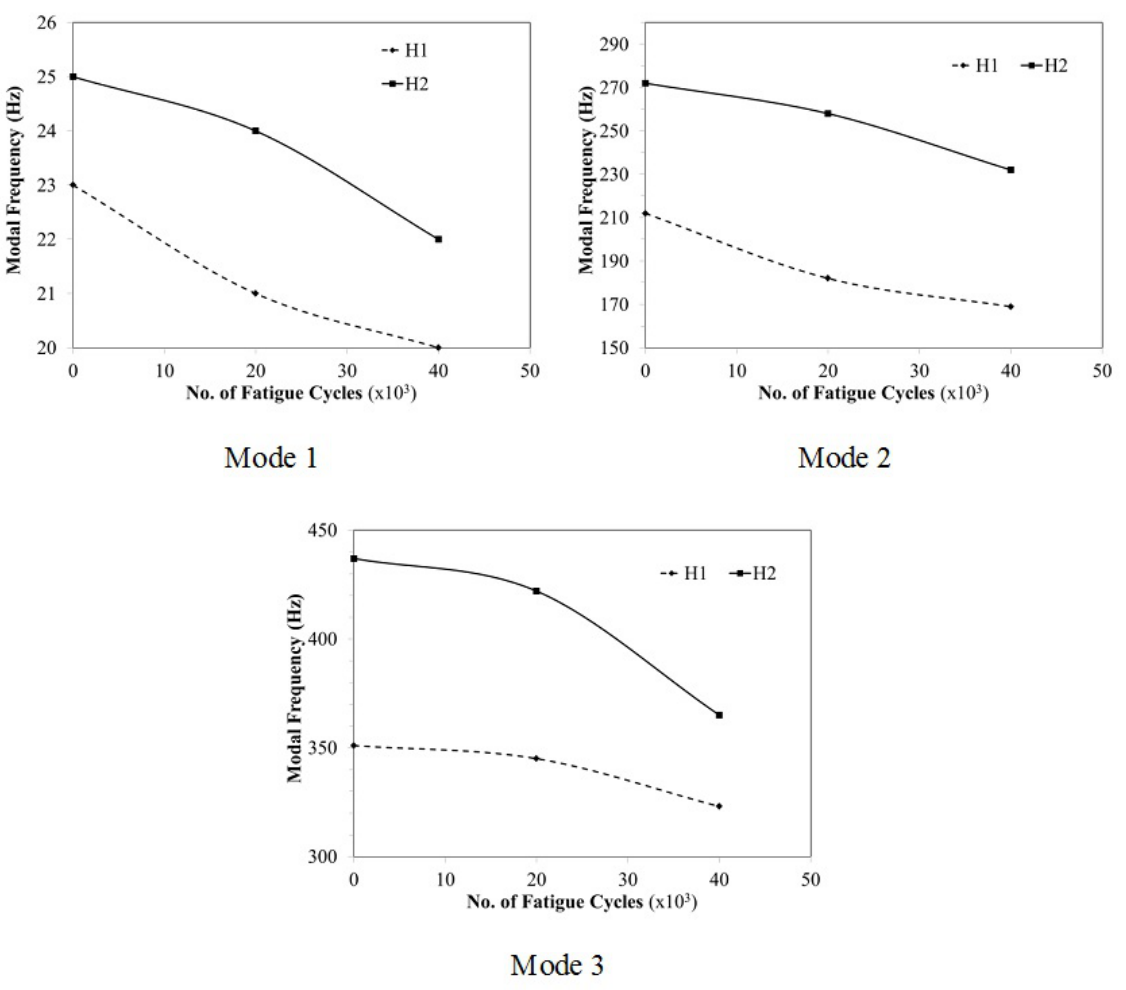
Fig. 12. Variation of Modal Frequency Values of Glass/Jute Hybrid Beams after limited cyclic loading at (a) Mode 1 (b) Mode 2 (c) Mode